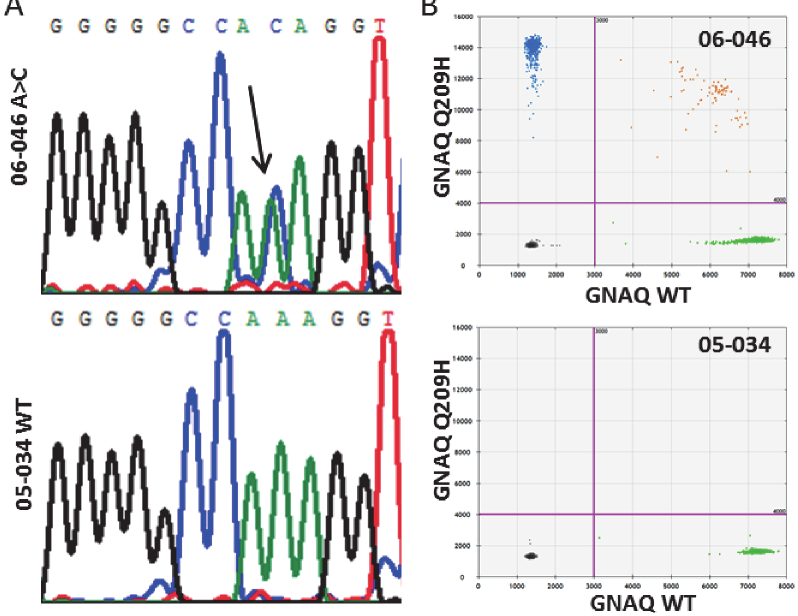
Fig 2. GNAQ A209H mutation in UM 06 – 046. (A) GNAQ mutation in 06 – 046 involves the c.627 A>C that encodes for the Q209H substitution. (B) For comparison, the WT sequence analysis of 05 – 034 is